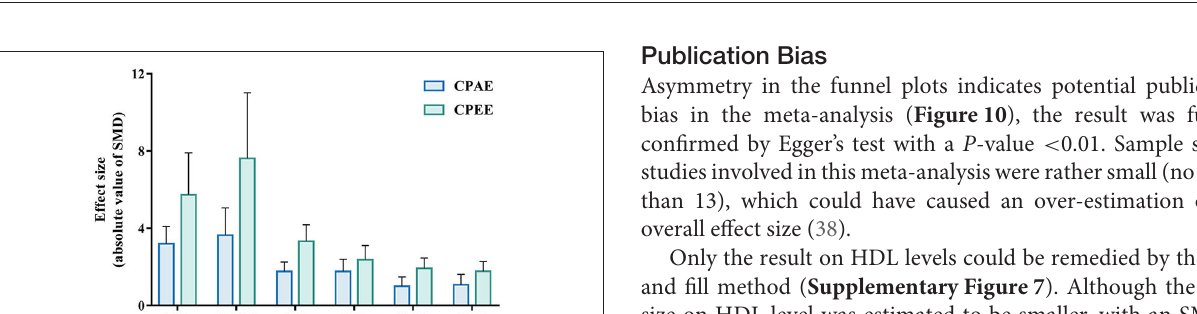
FIGURE 4 | Forest plot for the effect of Cyclocarya paliurus (CP) on area under curve of oral glucose tolerance tests in animal models. Subgroup analysis was performed according to doses.